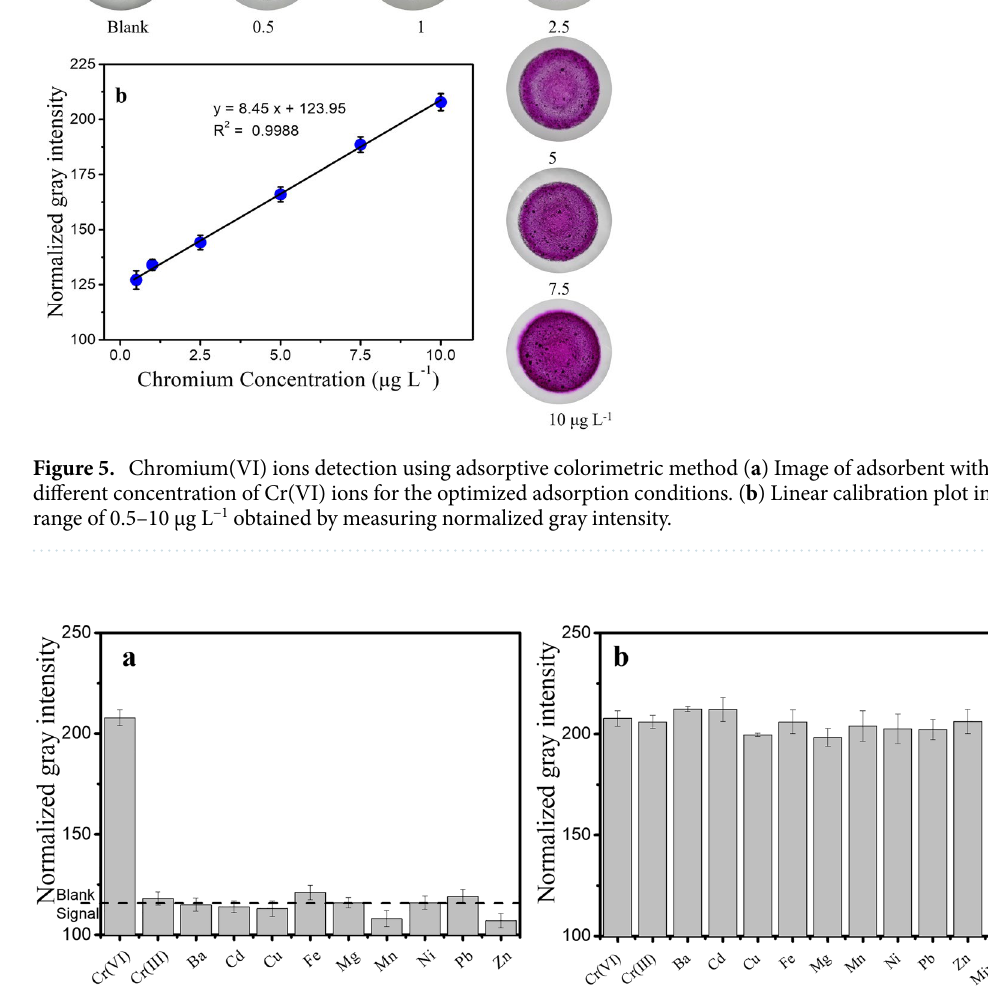
Figure 6. ( a ) Normalized gray intensities of chromium(VI) ions (10 µg L −1 ) and different metal ions (100 µg L −1 ) at the optimized adsorptive colorimetric reaction conditions. Blank signal represents background normalized gray intensity. ( b ) Normalized gray intensities of mixtures of chromium(VI) ions (10 µg L −1 ) with different metal ions (each at 100 µg L −1 ). Mixed indicates 10 µg L −1 each of all metal